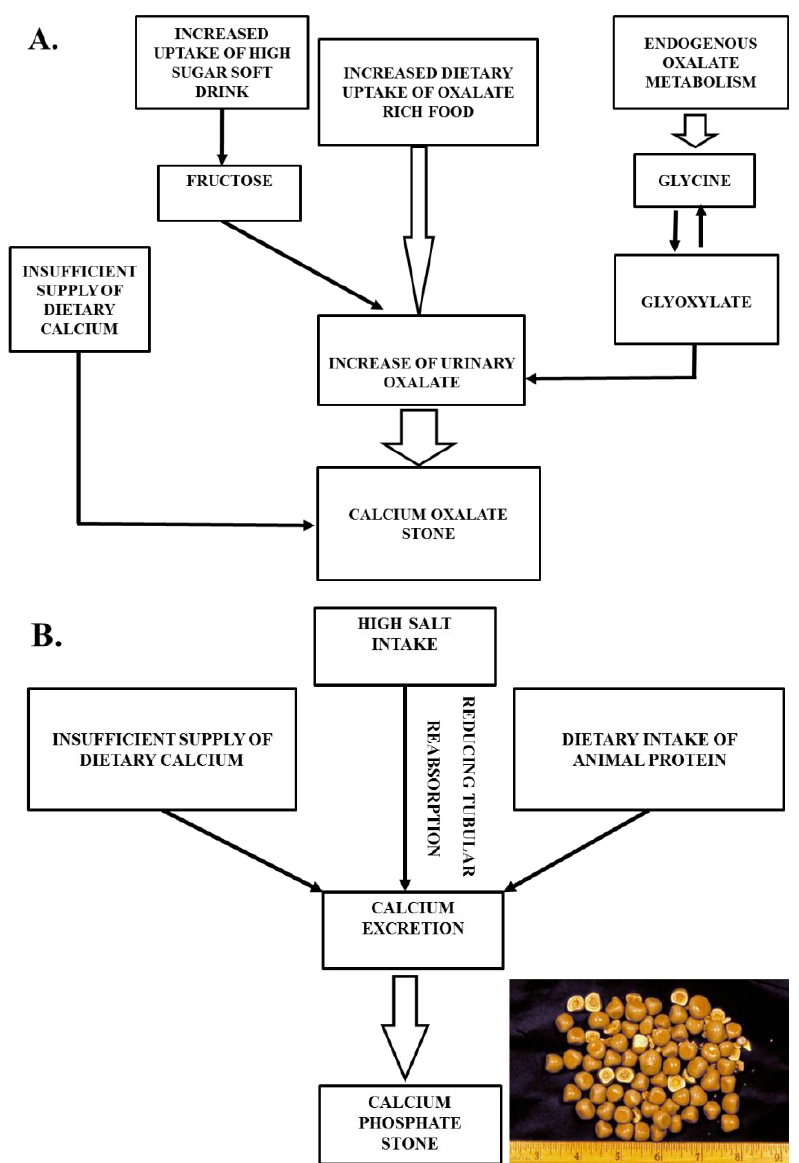
Figure 2. Calcium stone formation with food habits: ( A ) Calcium oxalate stone formation, and ( B ) calcium phosphate stone aggregation.